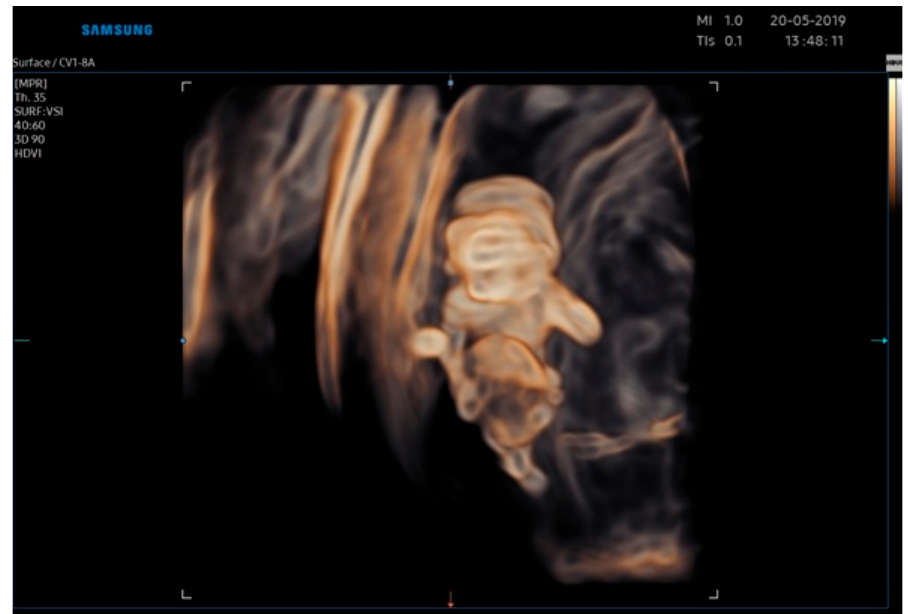
Figure 5. Crystal Vue image of case report 2 at 13 weeks.